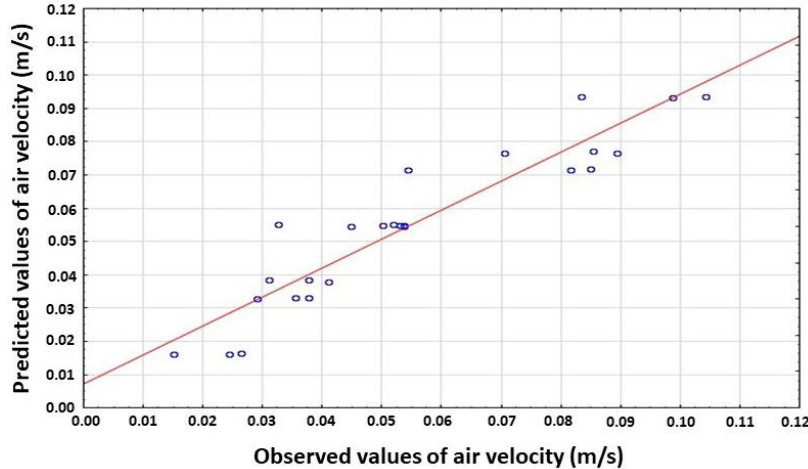
Figure 17. Predicted versus observed values of air velocity in the reaction cell with lateral air inlet and outlet geometry.